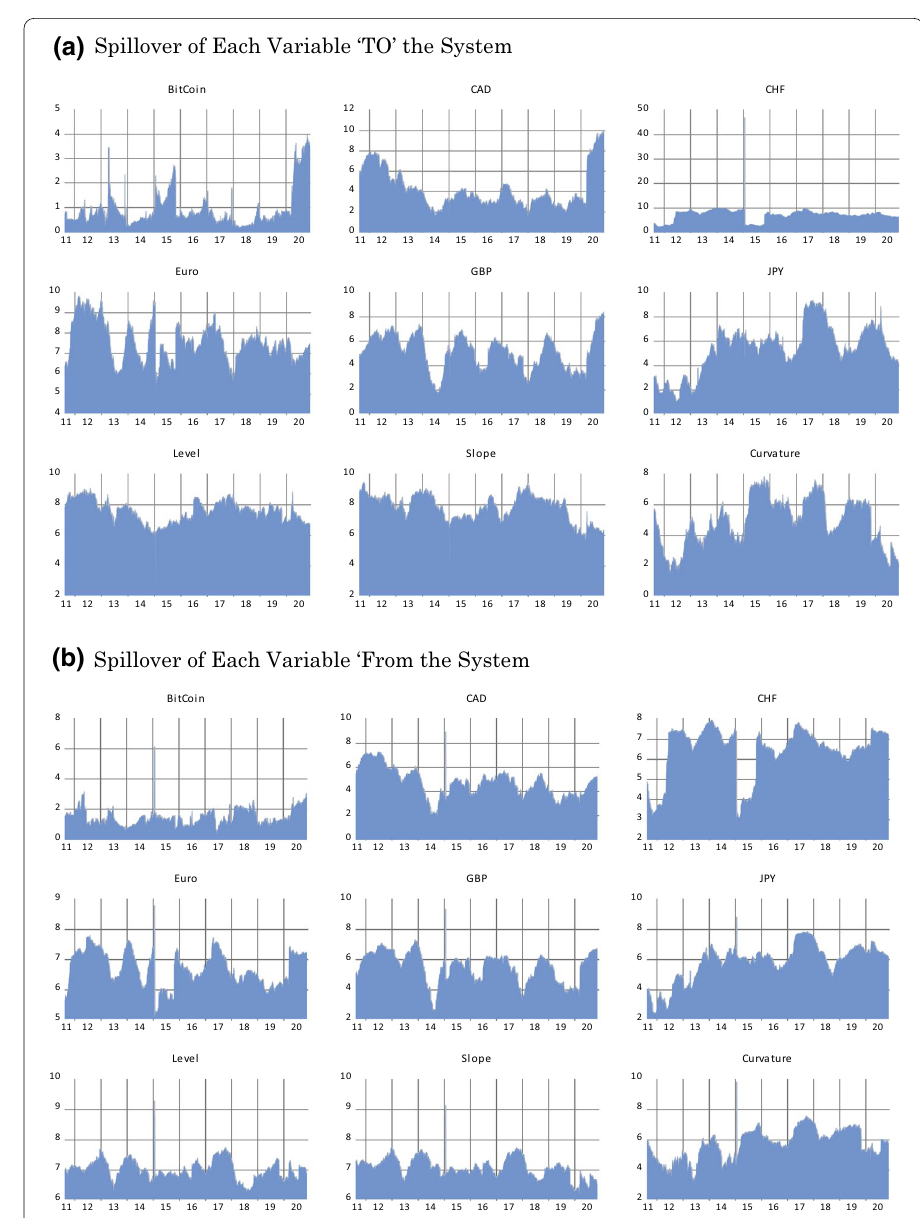
Fig. 6 Spillover ‘To’ and ‘From’ the System of the Components of the Yield Curve and the Exchange Rates of the Safe Haven Currencies and Bitcoin. a Spillover of Each Variable ‘TO’ the System. b Spillover of Each Variable ‘From the System. Notes : The figures describe the dynamic ‘TO’ and ‘FROM” spillovers between each variable and the whole system comprising the yield curve components and the exchange rate of Bitcoin and the safe haven currencies. The rest of the notations are as in Fig.